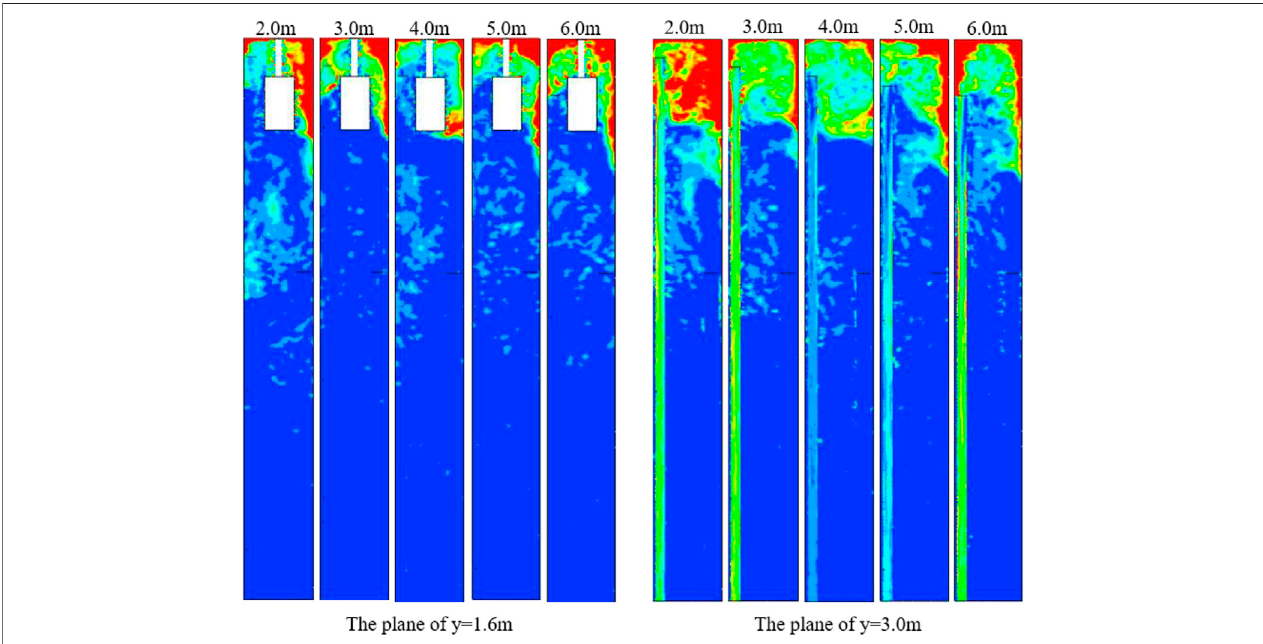
FIGURE 12 | Dust diffusion at planes of y = 1.6 and 3.0 m for different dedusting-air duct distances (roadheader).